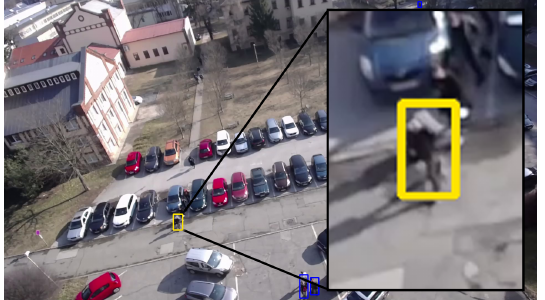
Figure 8. Estimating the position of a pedestrian—highlighted in the yellow